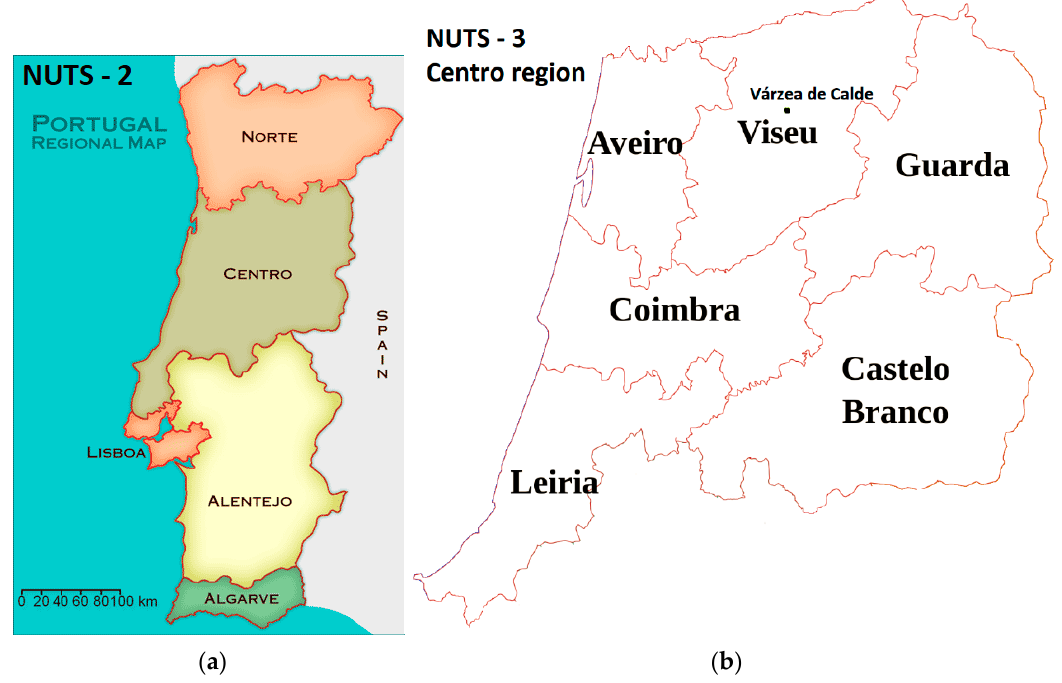
Figure 2. Regional map of Portugal NUTS 2 ( a ) (Alport 2019), Central region, and its districts NUTS 3 ( b ) (Own creation).